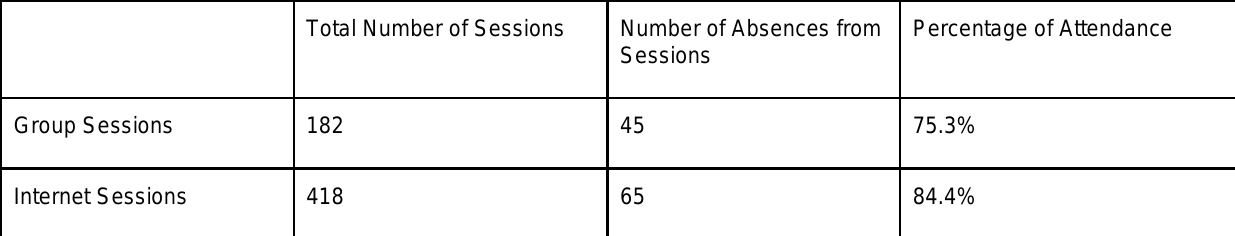
Table 4. Session